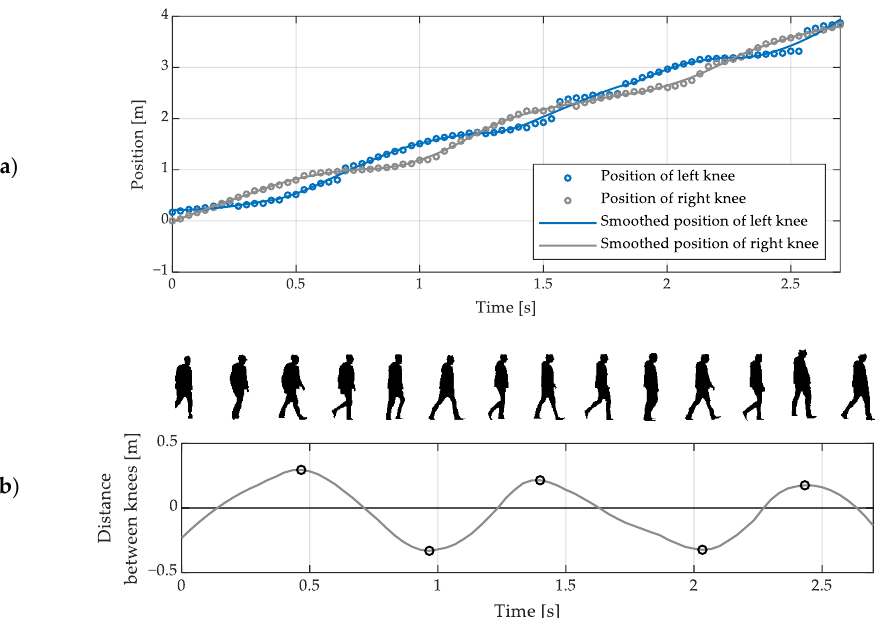
Figure 3. ( a ) Exemplary estimates of anteroposterior positions of knees during walking, obtained using a depth sensor, and the results of their smoothing using a Savitzky-Golay filter; ( b ) An exemplary dependence of the anteroposterior distance between a walking person’s knees on time, with its local extrema indicated with circles and the silhouettes of that person extracted from the corresponding depth images.